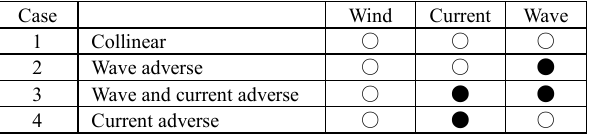
Table 2. Combination of wind, wave, and current directions.